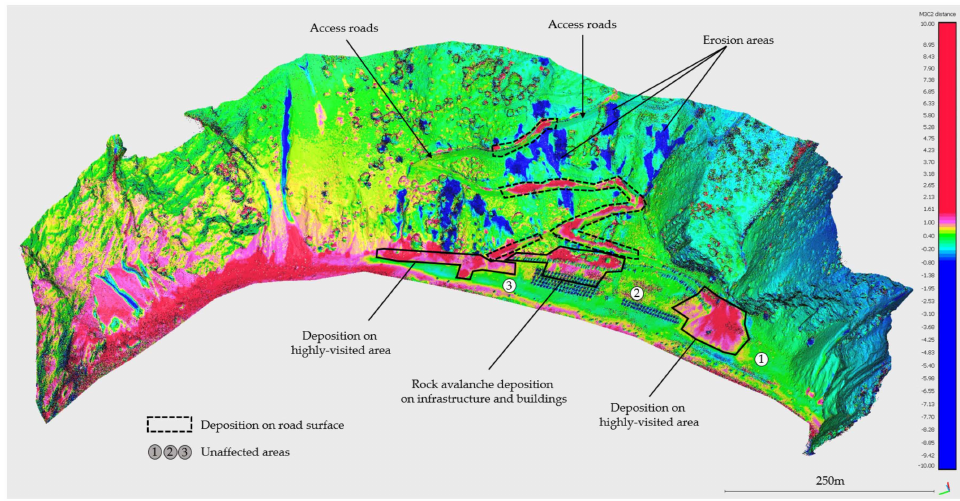
Figure 12. A perspective pseudo-3D view of the affected area, with a color scale showing vertical changes (erosion and deposition), and the distinctly affected elements (including high-visitation areas, infrastructure, and buildings), parts of the access road that suffered deposition from debris flows and rock avalanches, indicating the higher risk parts of the site, as well as the unaffected areas of Myrtos.